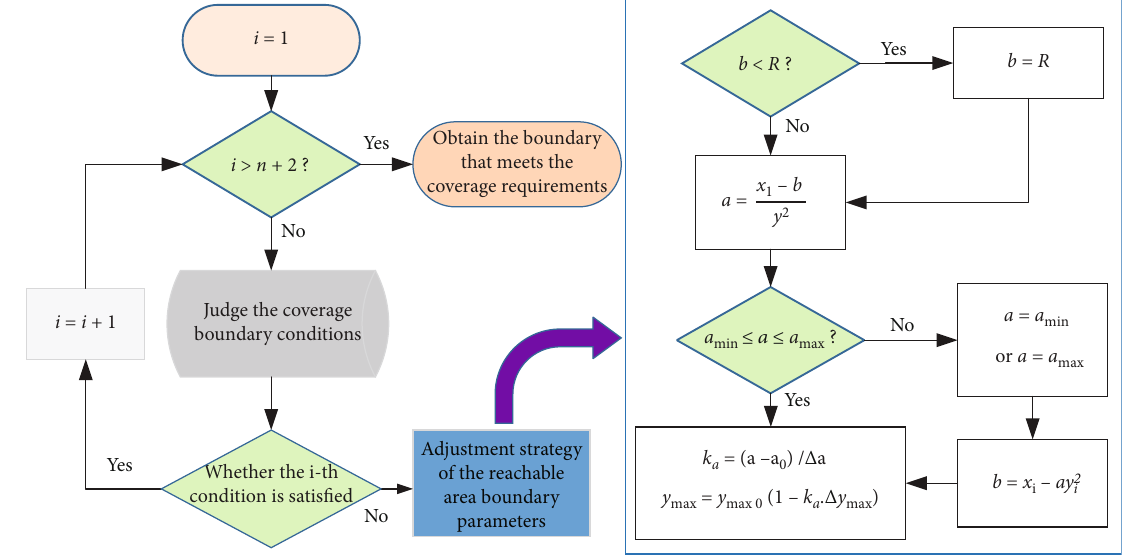
Figure 6: Adjustment strategies for the reachable area boundary